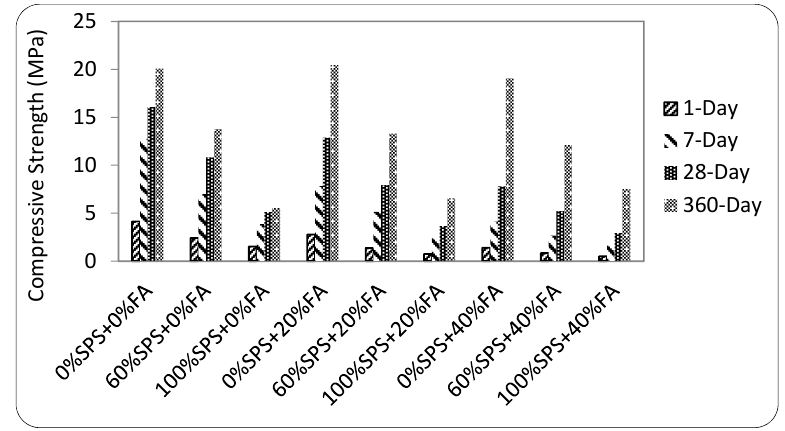
Figure 6. Effect of SPS and FA on compressive strength at different ages.